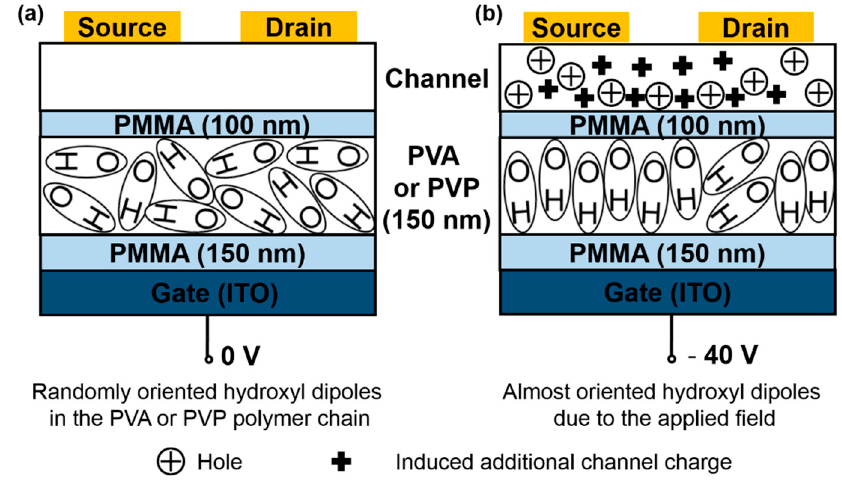
Figure 4. ( a ) Schematic illustration of disorder hydroxyl groups in polar dielectric layer; and ( b ) oriented hydroxyl groups due to applied gate voltage.